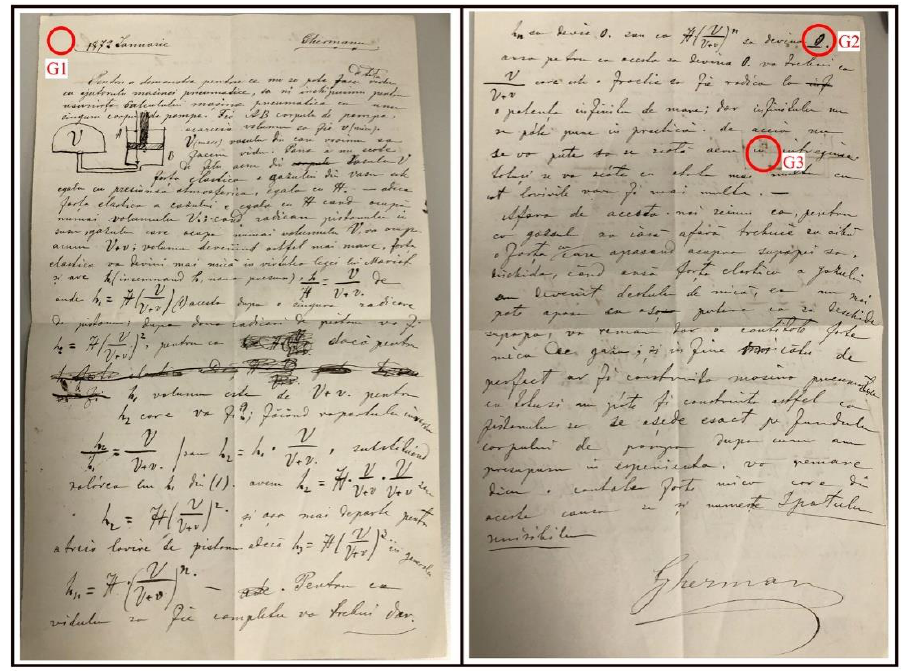
Figure 2. Student Gherman’s physics test—S2 and the analyzed areas (G1, G2 and G3).